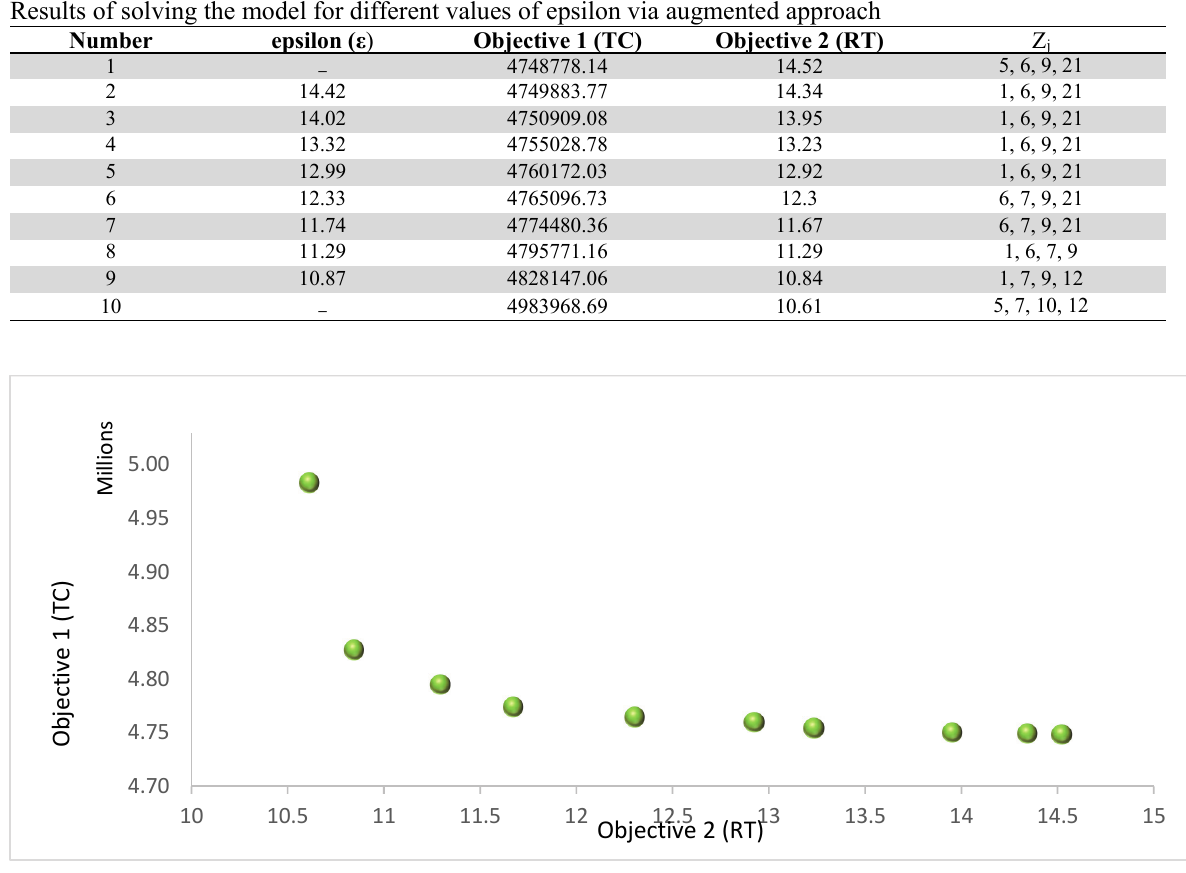
Fig. 8. Pareto points obtained via the augmented approach